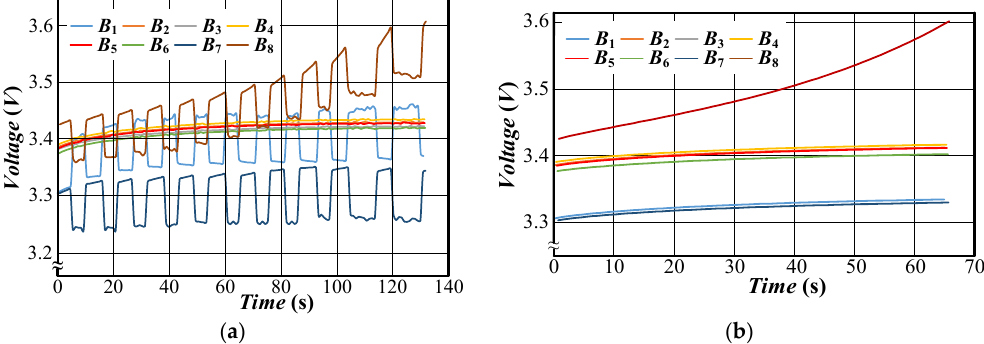
Figure 13. Variation in the voltage in the special case: ( a ) with balancing; ( b ) without balancing. Table 5. Battery voltages in the special case.